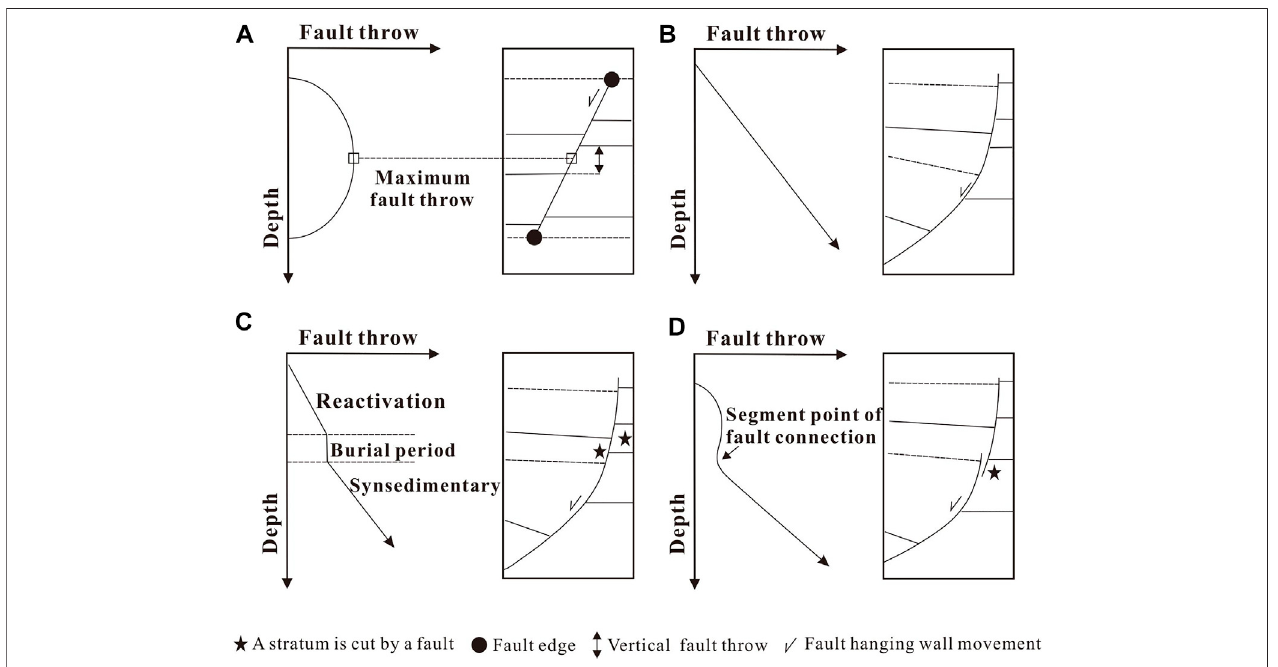
FIGURE7| Themodeldiagramofthefaultthrow-depthcurve. (A) Isolatedfaulttype; (B) continuousgrowthtype; (C) faultreactivationtype;and (D) dipconnection type. Modi fi ed from Wang et al. (2020).